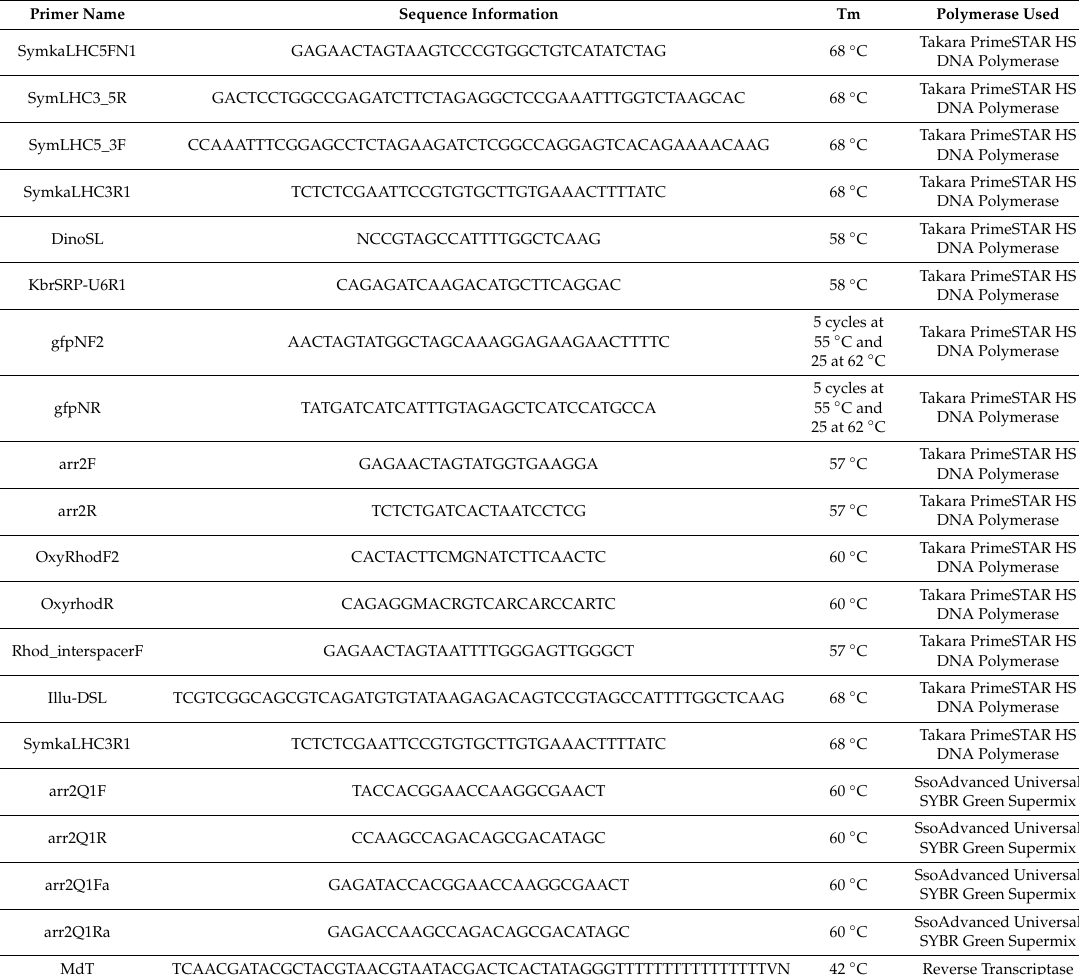
Table 2. Primers used in the present